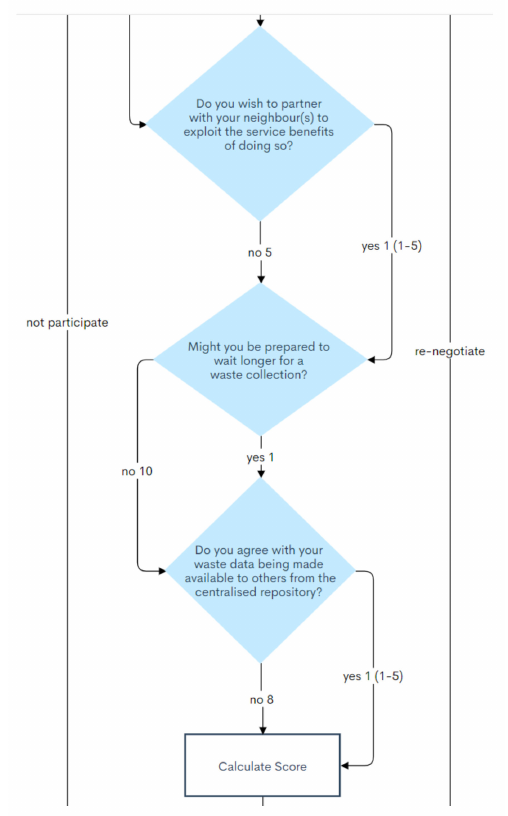
Figure 4. Second phase of scoring a customer for